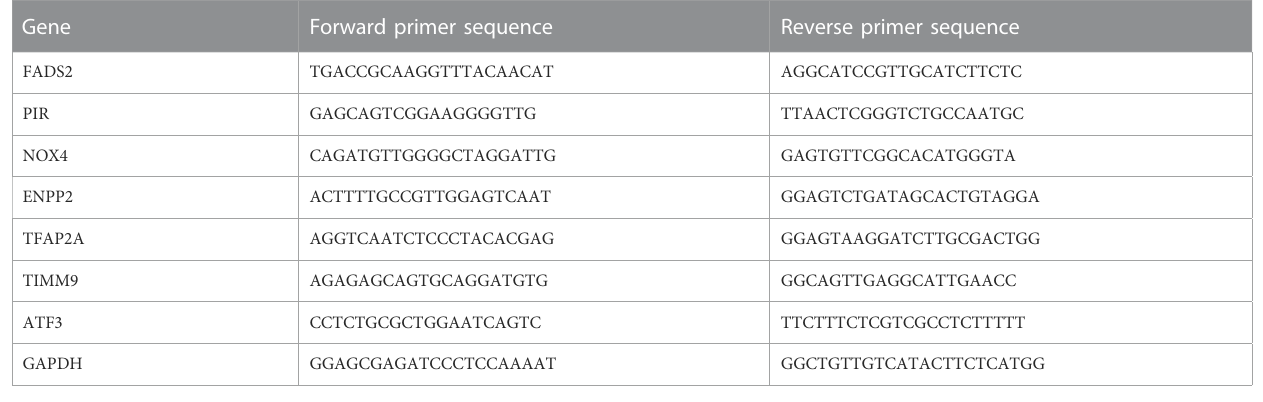
TABLE 2 Sequences of the RT-PCR primers used for each gene. Gene